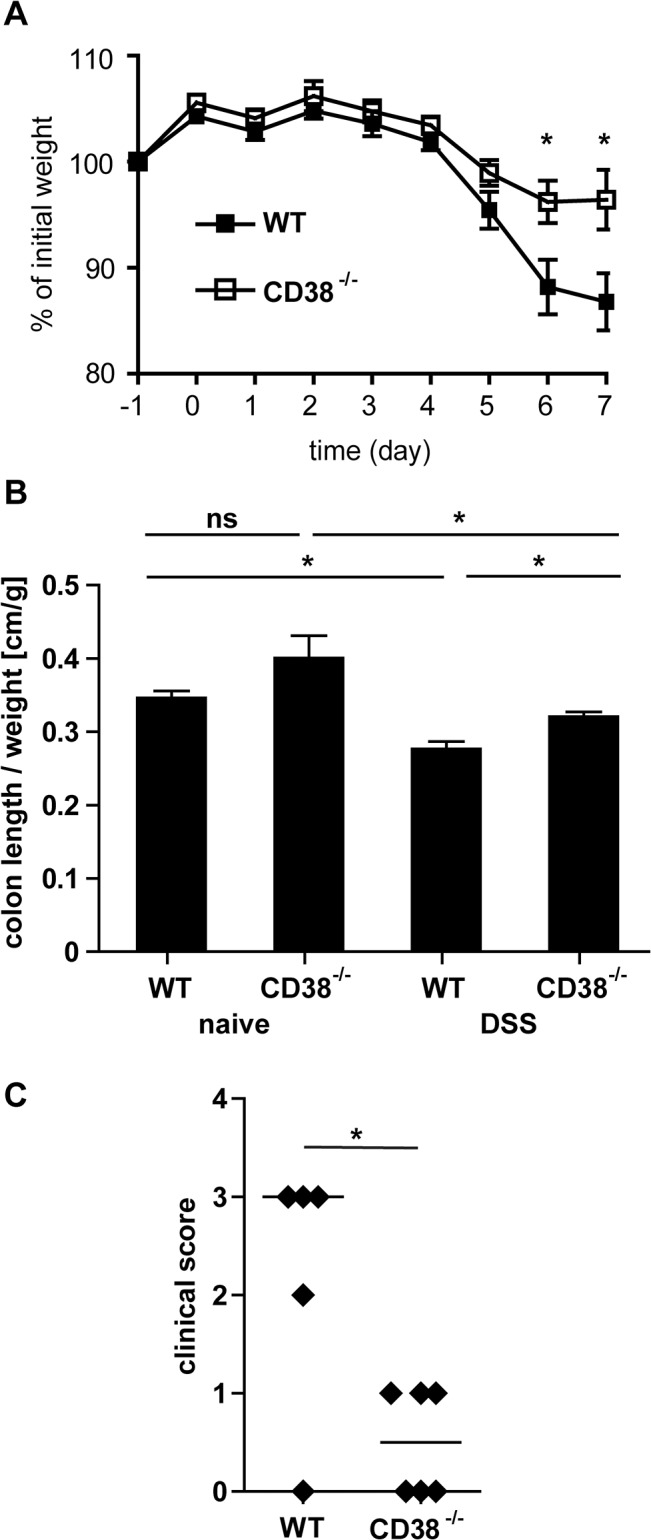
CD38-/- mice develop only mild colitis in response to DSS-treatment.Wild-type and CD38-/- mice were treated with DSS as in Fig 1. On day 7, mice were killed and colons were analyzed. (A) Weight changes of wild-type and CD38-/- mice after DSS treatment. Weight was determined daily and is given as % of weight one day before the beginning of DSS treatment. Results represent the mean ± SEM of 6 individually analyzed mice per group. (B) Relative colon length of untreated and DSS-treated wild-type and CD38-/- mice. Colon length was normalized to the whole-animal body weight, which was determined before DSS treatment. Bars give the mean ± SEM of 5 or 6 individually analyzed mice per group. (C) Clinical score of DSS-treated wild-type and CD38-/- mice at day 7. Parameters of scoring are given in the method section. Values for individually analyzed mice and the median are shown. * p<0.05; ns not significant (p>0.05)